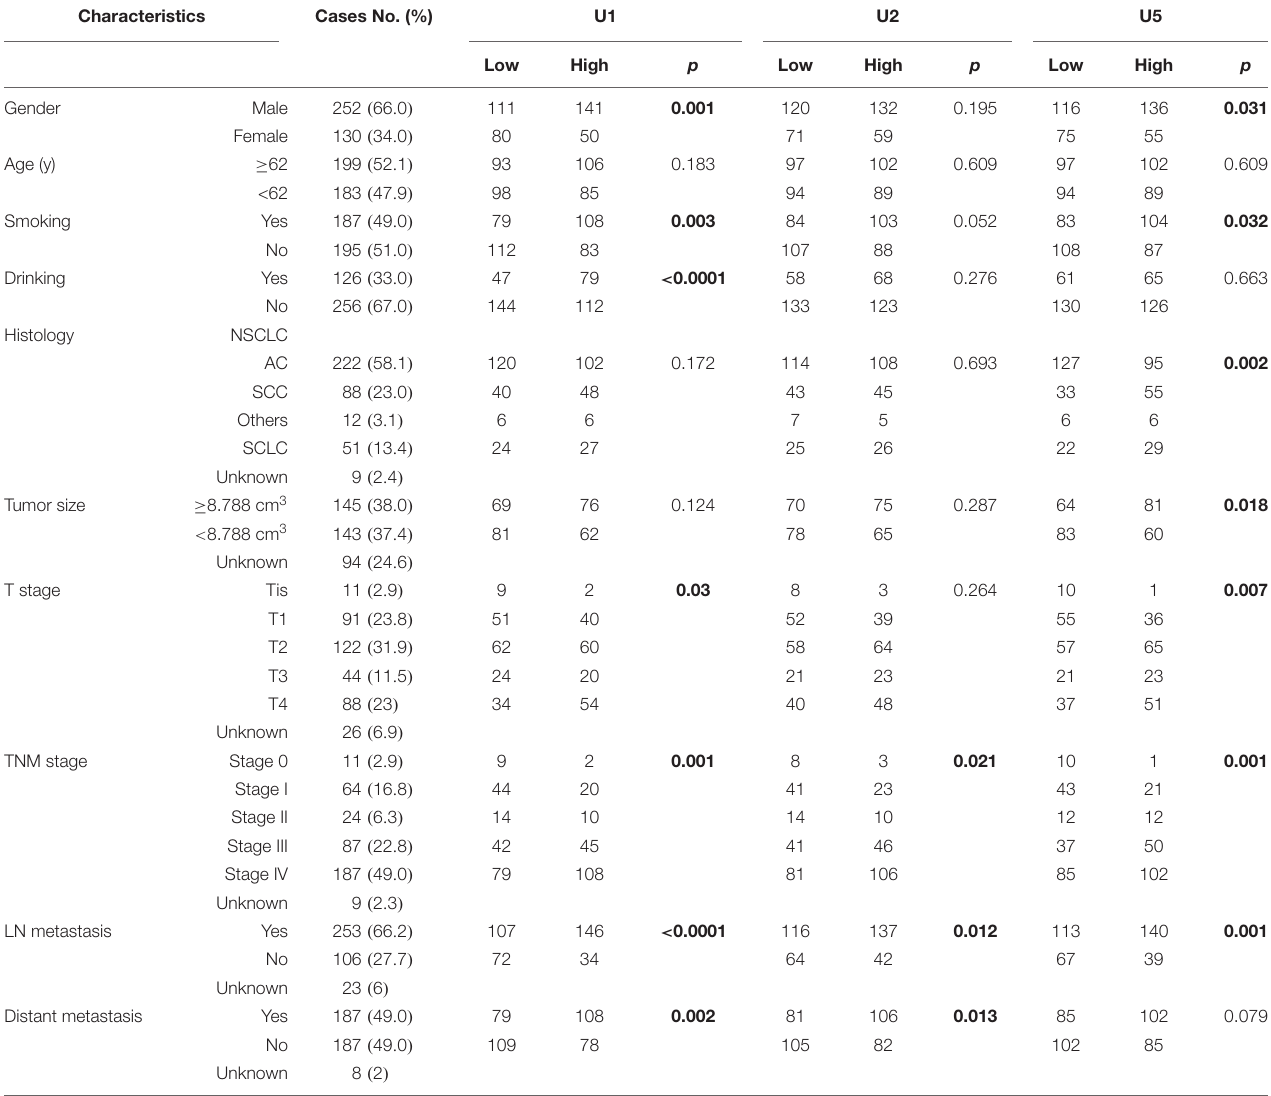
TABLE 2 | Correlation between TEP U1, U2, U5 expression and clinicopathologic characteristics of lung cancer patients.